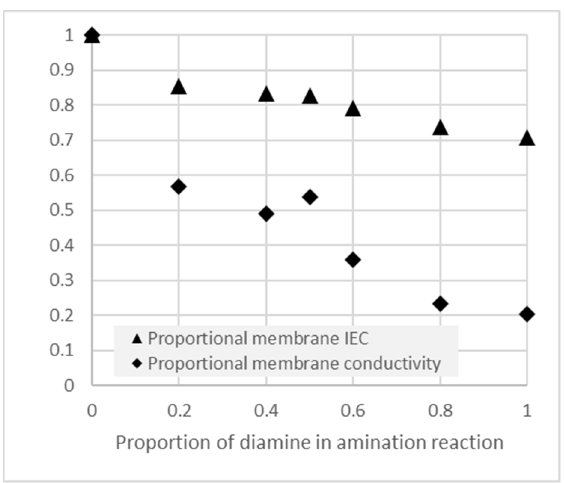
Figure 6. IEC and conductivity of crosslinked AEM’s, as a proportion of the uncrosslinked values, following amination reactions with varying proportions of the crosslinking diamine (TMHDA) together with the non-crosslinking monoamine (TMA).